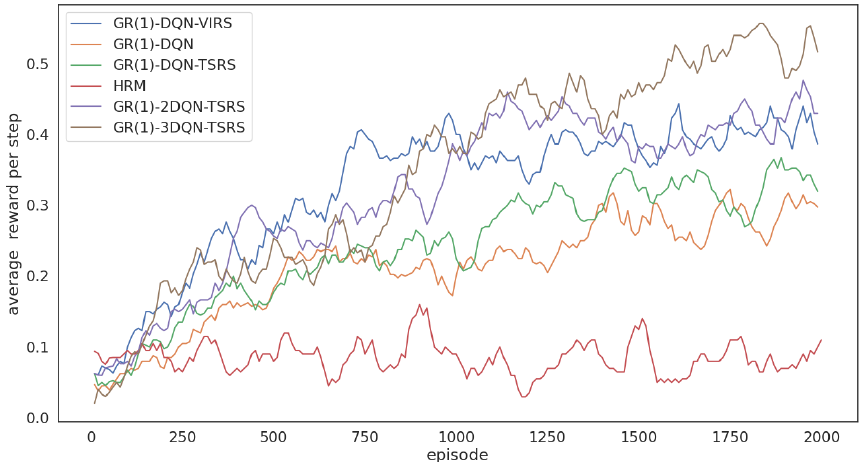
Figure 13. Comparison of learning curves for multi-task reinforcement learning algorithms with ϕ 2 under stochastic environment setting